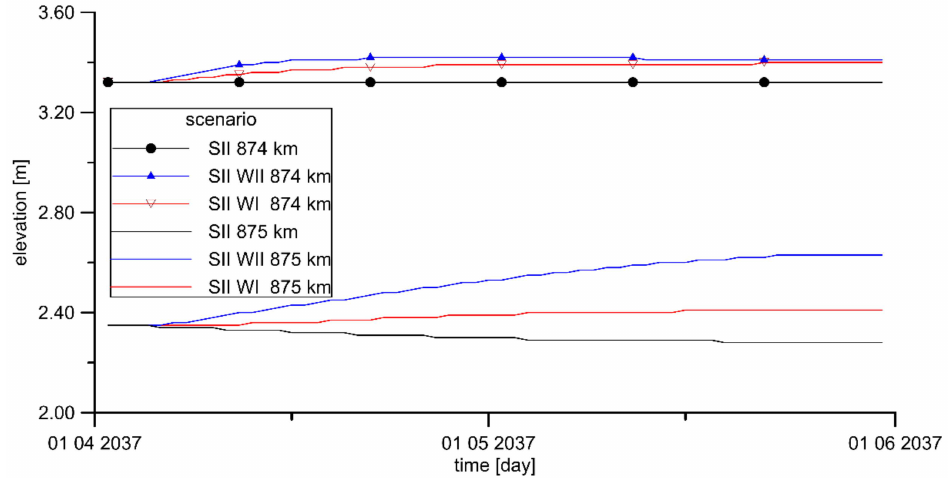
Figure 11. Changes in the bottom elevation for km 875.123 and km 874.648 for options without flushing and with flushing in options I and II for the first flushing period after construction of the Gniew Barrage.